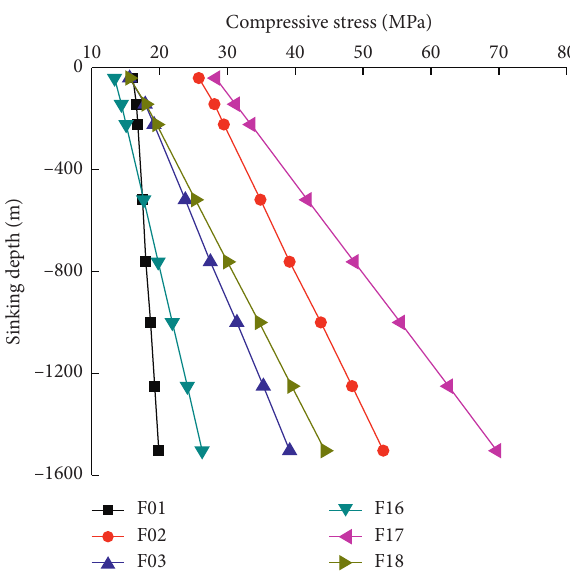
Figure 5: Theoretical stress curve of upper supporting bars under different working